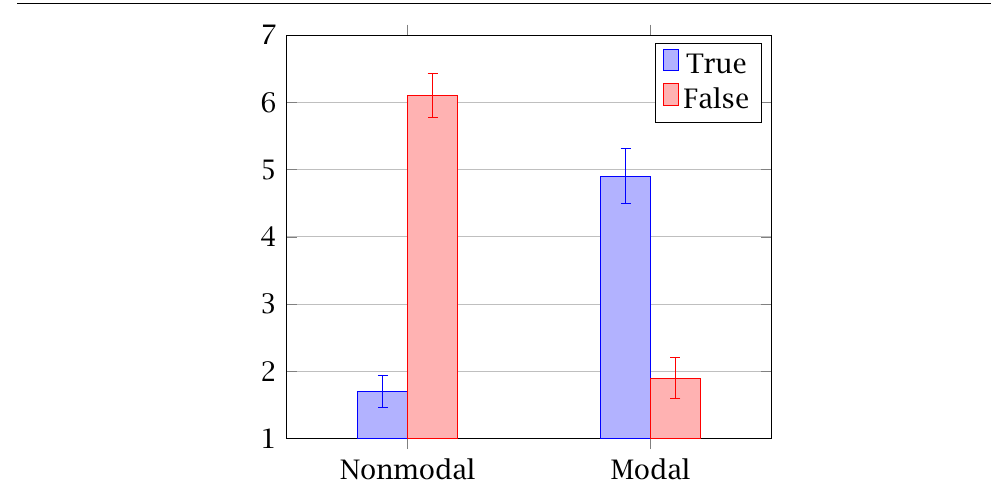
Figure 1 Mean ratings by condition for Experiment 1 . Error bars show standard error of the